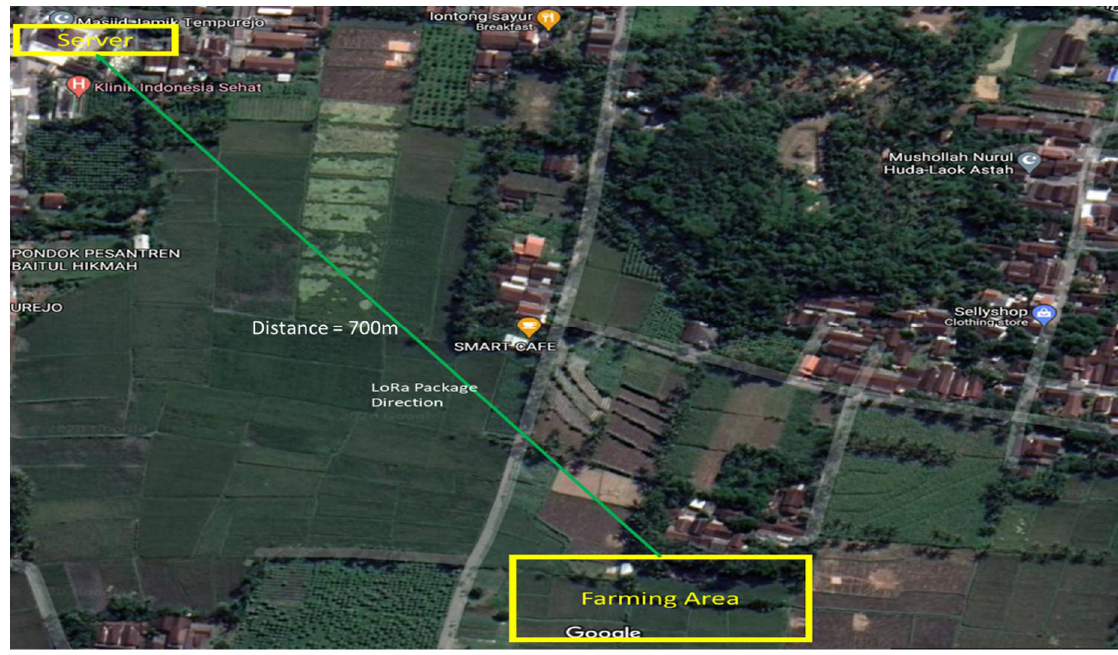
Figure 6. Delay measurement scheme.